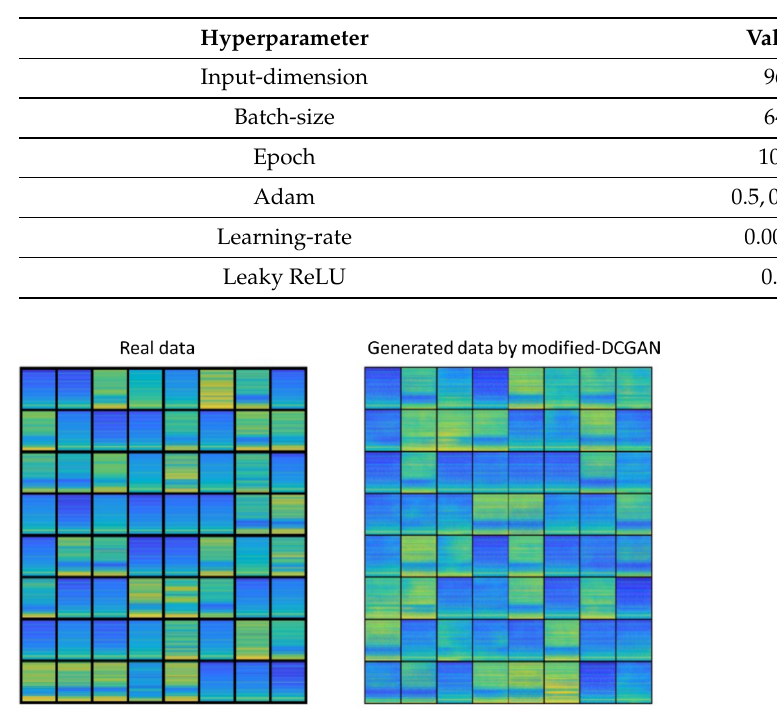
Table 4. Hyperparameter settings of modified DCGAN model.